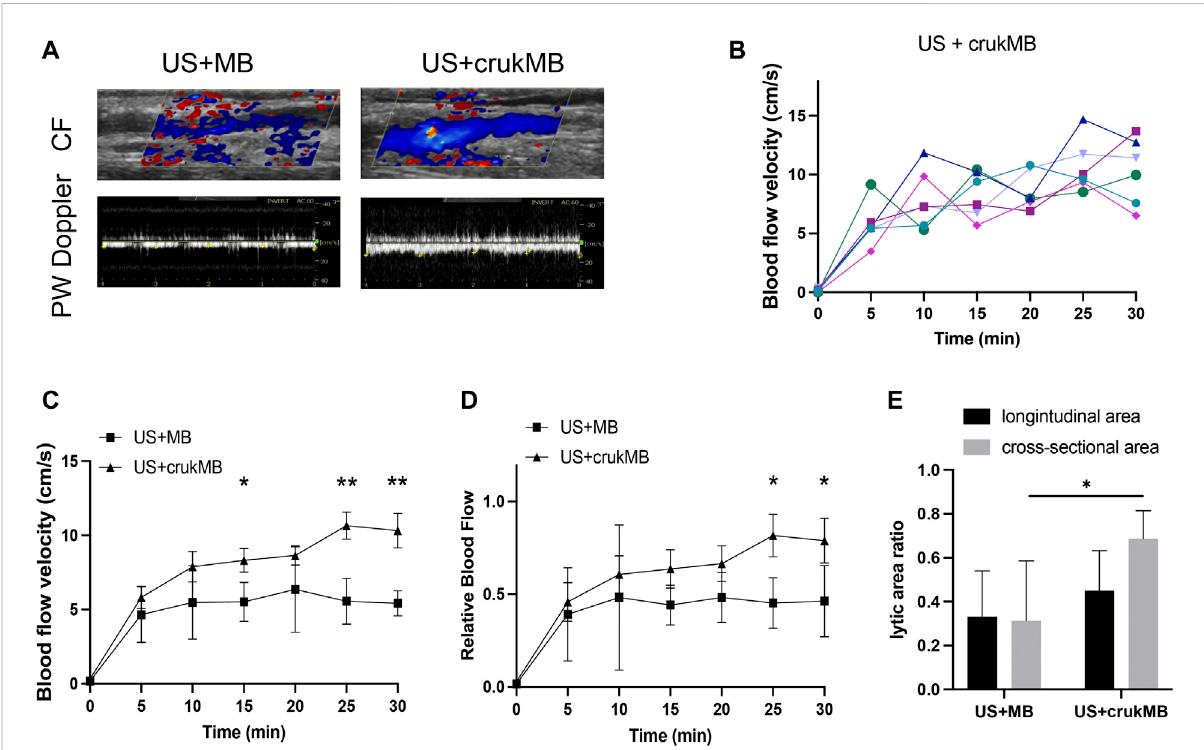
Enhanced sonothrombolysis with crukMB in vivo . (A) Ultrasonic evaluation of IVC thrombus after 30 min treatment. (B) Blood fl ow velocity curves in the US + crukMB group, each curve represents a treatment sample. (C) Blood fl ow velocity curves in 30 min treatment in vivo. (D)